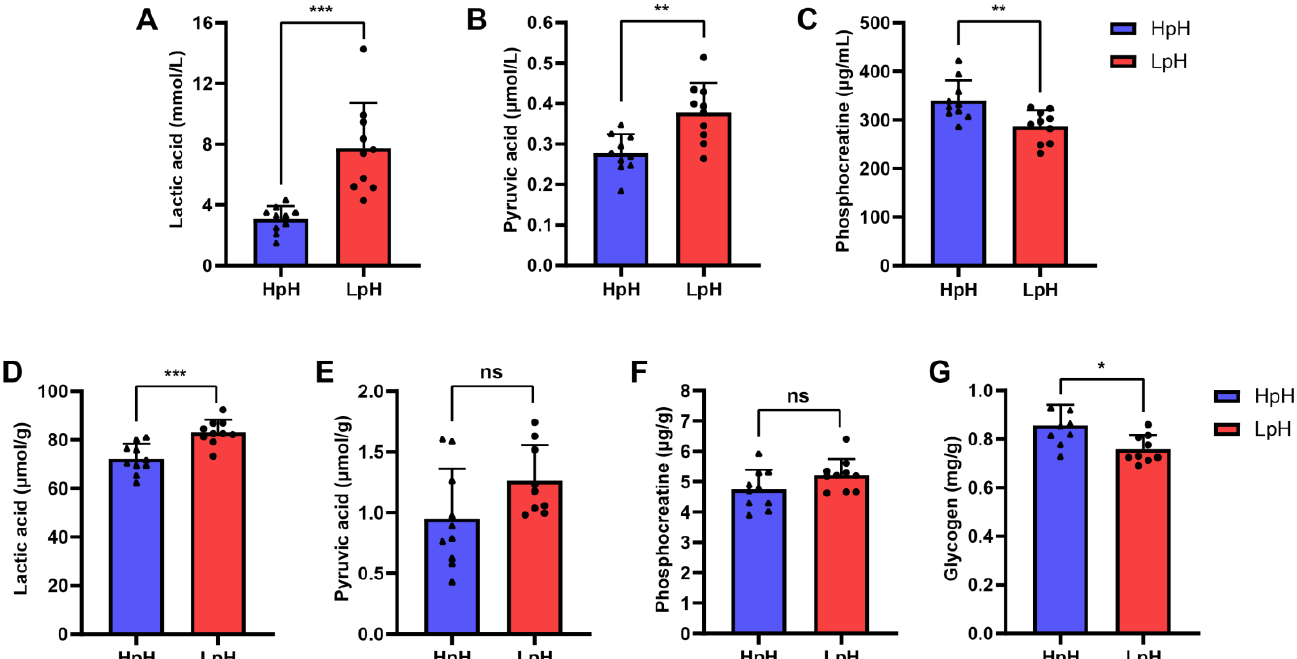
Figure 2. Content of metabolites in porcine plasma and longissimus thoracis et lumborum (LTL) muscle. Lactic acid ( A ), pyruvic acid ( B ), and phosphocreatine ( C ) contents in plasma. Lactic acid ( D ), pyruvic acid ( E ), phosphocreatine ( F ), and glycogen ( G ) contents in LTL muscle. The results are presented as means ± SEM (n = 10). Significant differences were determined by unpaired t -test (ns: no significant difference; * p < 0.05; ** p < 0.01; *** p < 0.001). HpH: muscle tissue with high pH; LpH: muscle tissue with low pH.